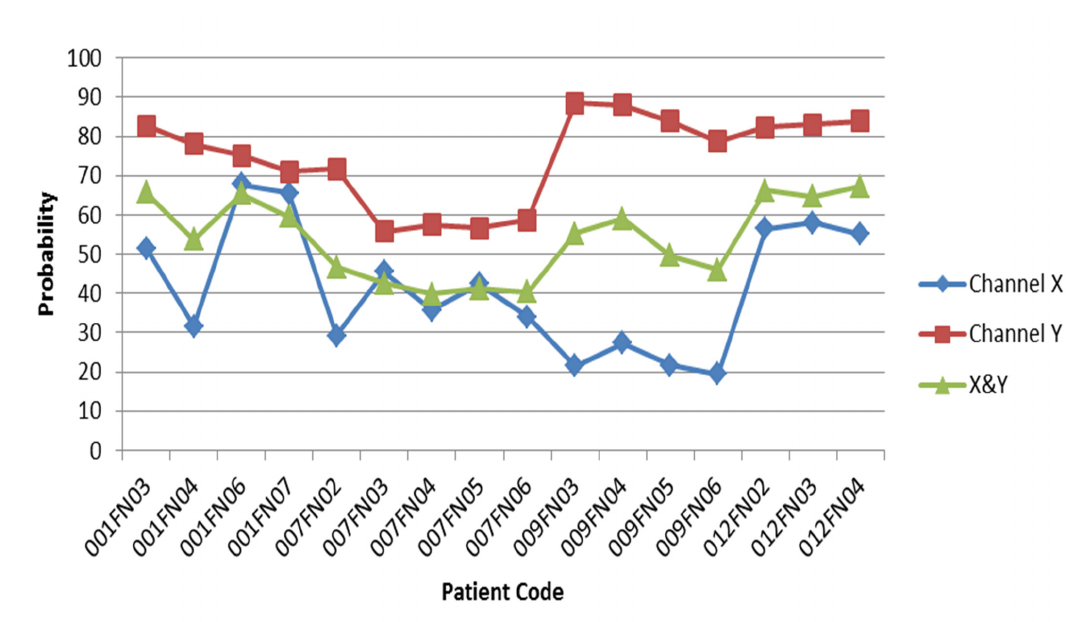
Figure 8. Probability of stimulation from the kinematic module for axis x, y and xy